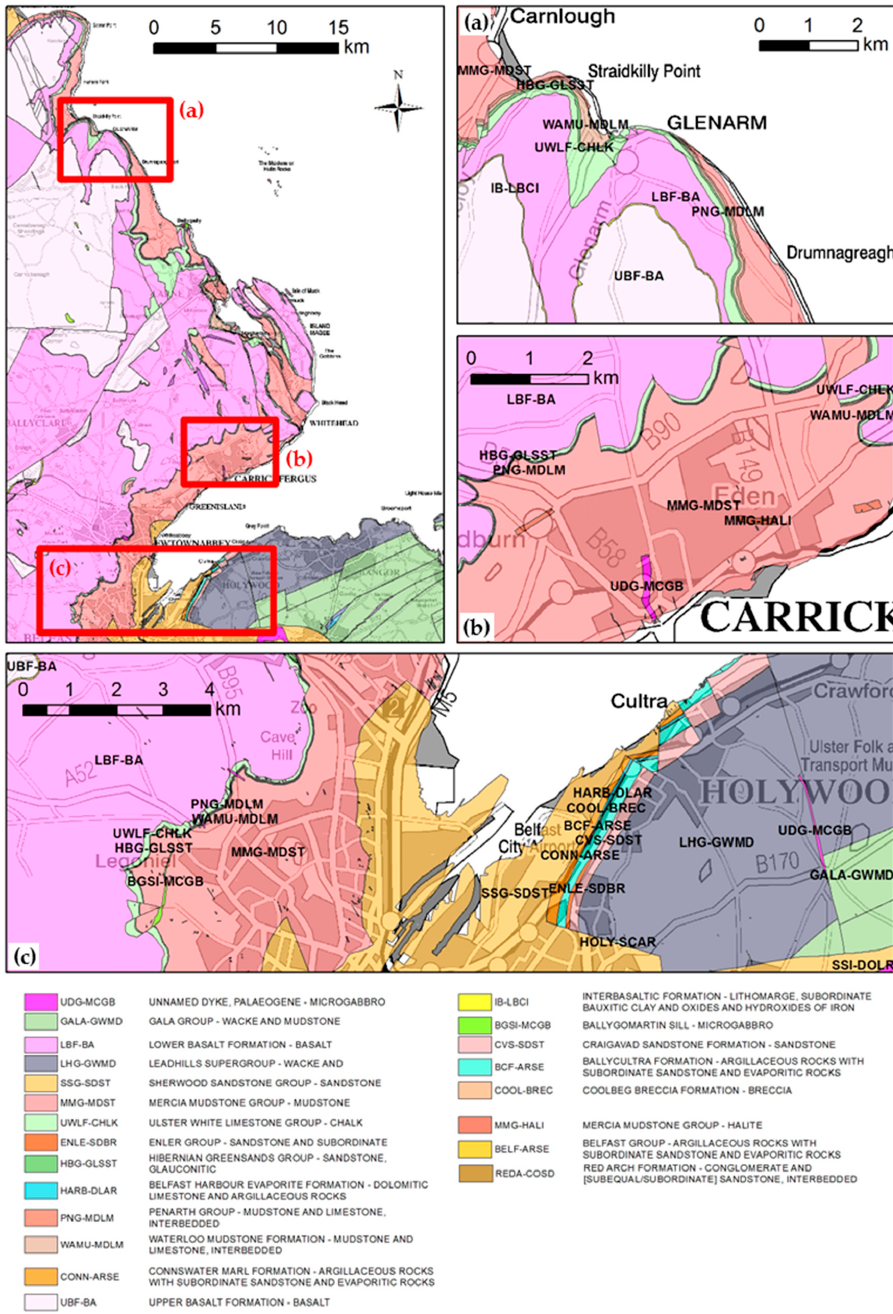
Figure 3. Bedrock geology of the study areas at 1:10,000 scale overlapped onto topography at 1:250,000 scale. ( a ) Straidkilly; ( b ) Carrickfergus mines and ( c ) Bangor Rail Line, Ligoniel Park and Throne Bend. Reproduced from Land and Property Services data with the permission of the Controller of Her Majesty’s Stationery Office, © Crown copyright and database rights MOU203.